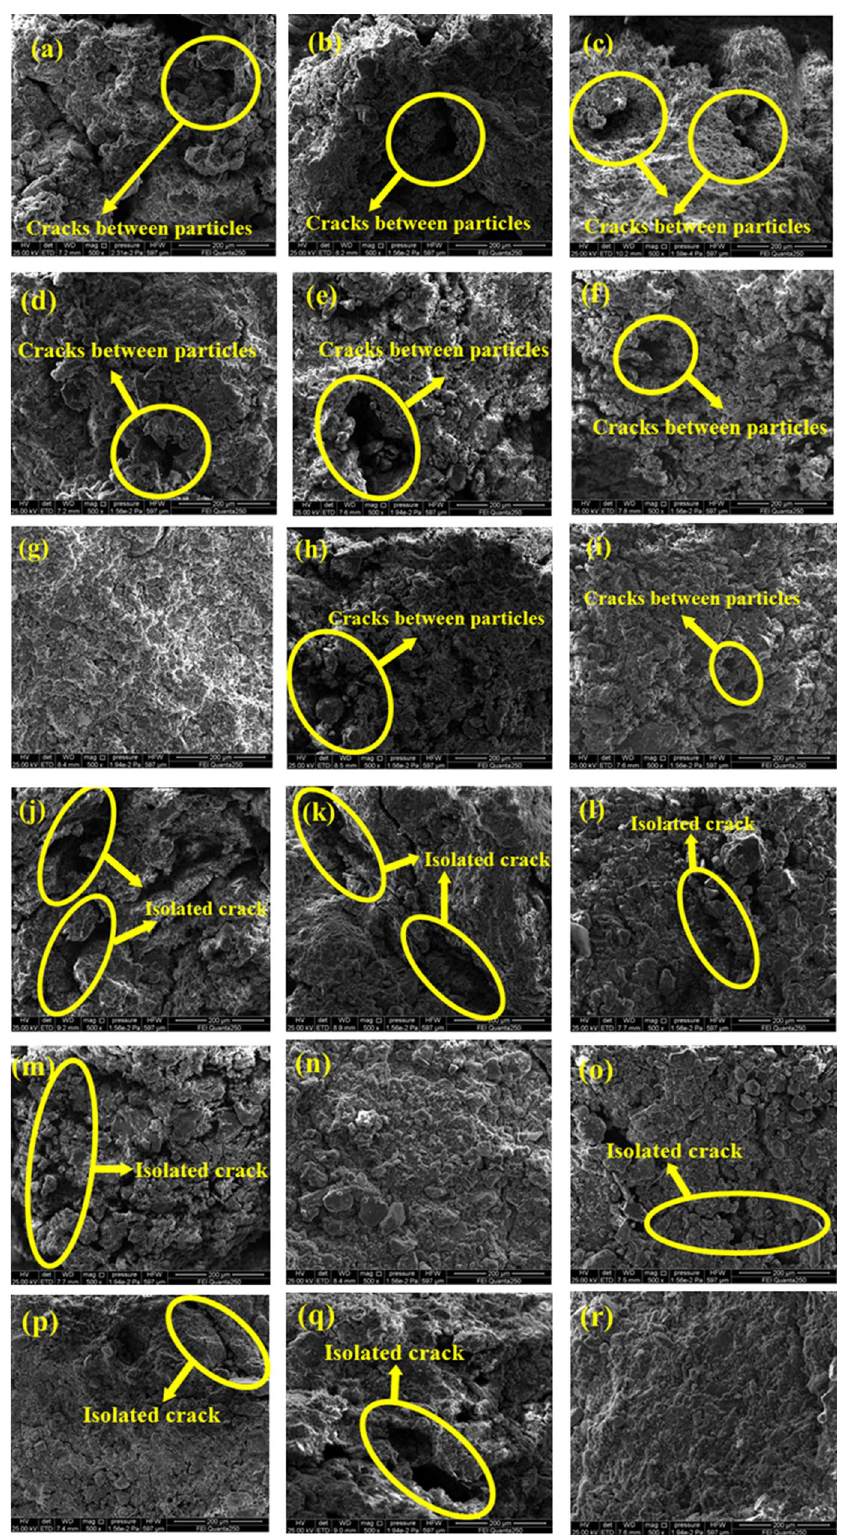
Figure 12. SEM results of drying shrinkage and freeze–thaw orthogonal test. ( a ) A 1 B 1 C 1 , ( b ) A 1 B 2 C 2 , ( c )